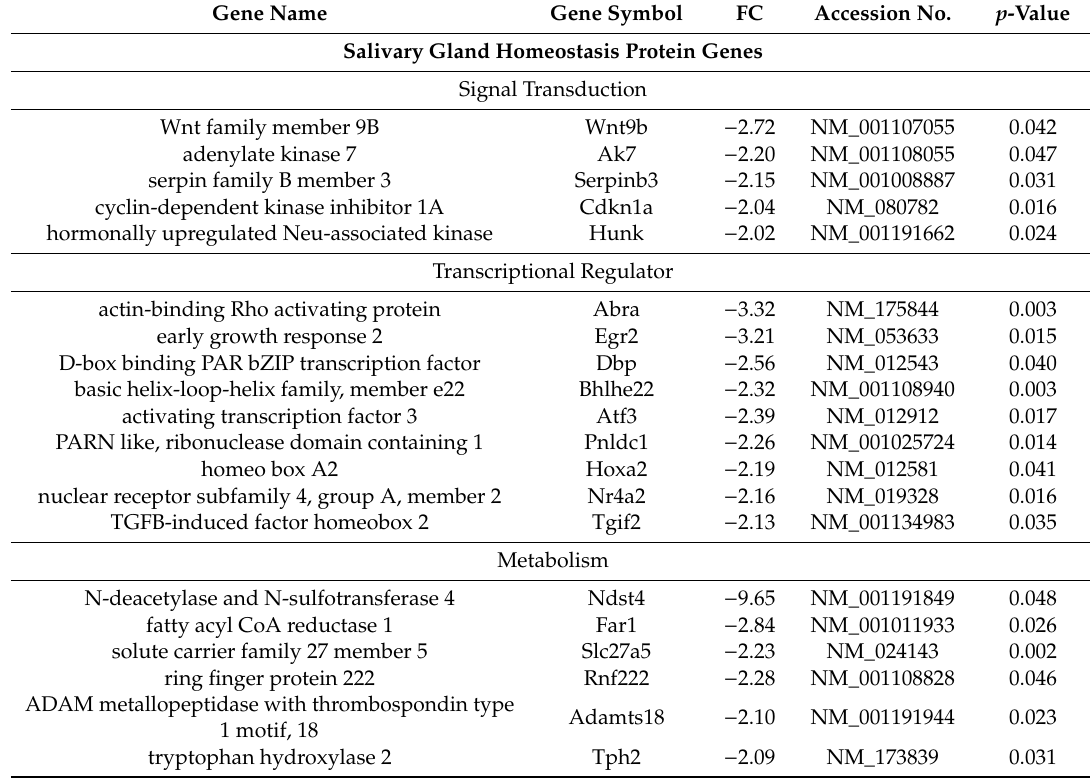
Table 4. Genes down-regulated by > 2.0-fold ( p < 0.05) in SLGs from LHK-treated group compared to those from water-treated group.